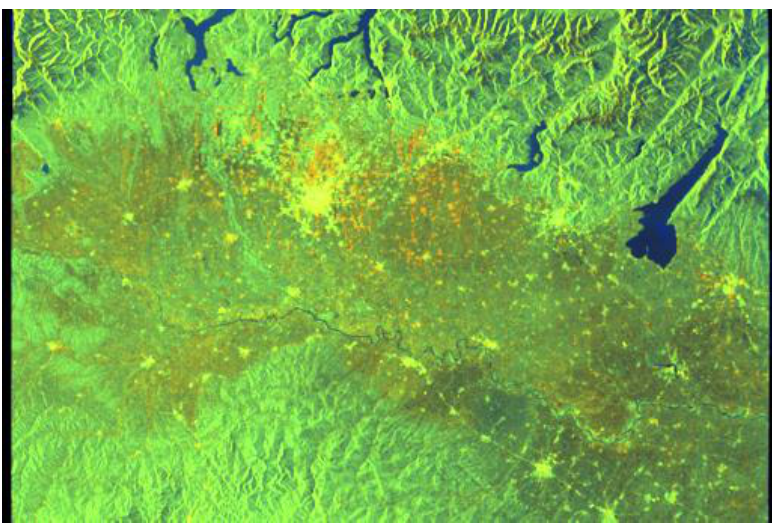
Figure 19. Quick-look of the Sentinel-1 GRD product exploited for the simulation of the decorrelating GEO SAR data scene.